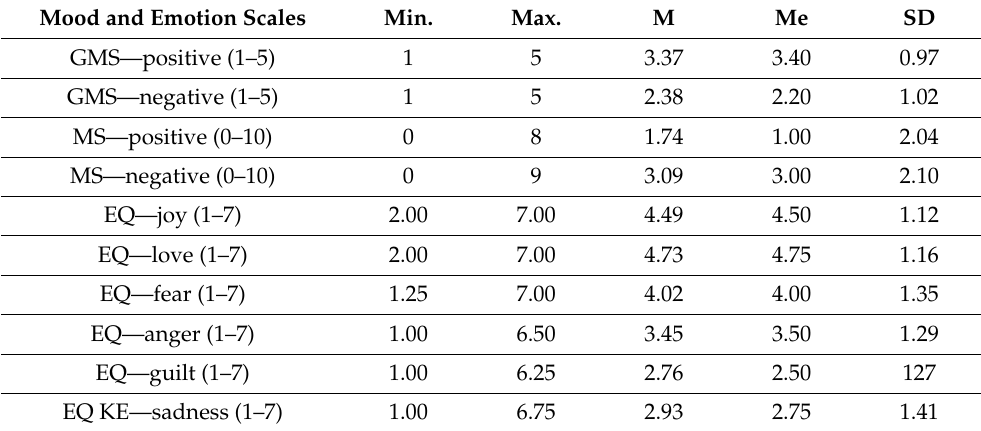
Table 2. Descriptive statistics of the mood and emotion scales, taking into account all the respondents as a whole. Mood and Emotion Scales Min. Max. M Me SD GMS—positive (1–5) 1 5